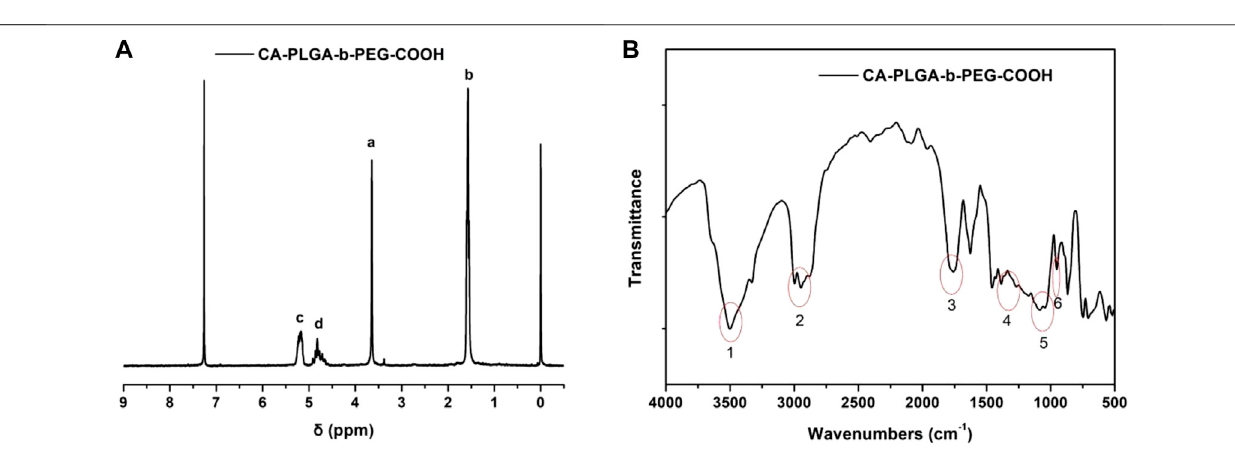
Frontiers in Bioengineering and Biotechnology |